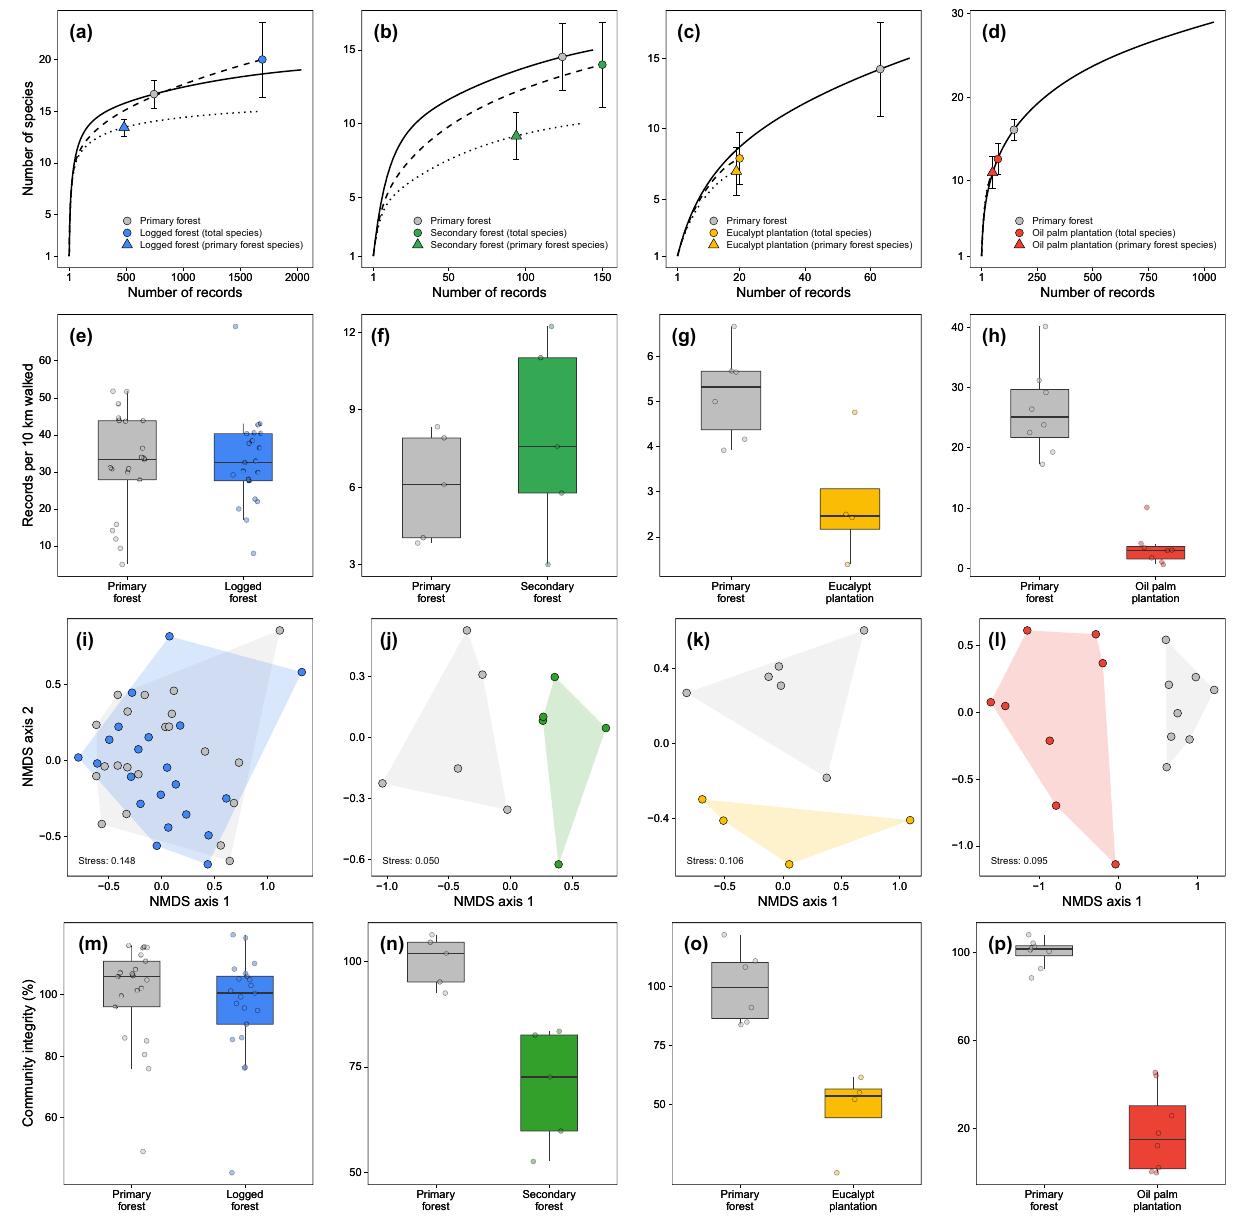
Figure 2. Mammal assemblage-wide metrics for human-modified and adjacent primary forest within each landscape: ( a – d ) rarefied total species richness in modified habitat and the adjacent primary forest, and rarefied number of primary forest species retained in modified habitat; ( e – h ) species abundance (number of records per 10 km walked); ( i – m ) species composition , represented in an ordination diagram obtained using the first two NMDS axes; and ( n – q ) community integrity , defined as the degree of similarity between disturbed and undisturbed habitats. Within each landscape, sampling sites are represented by dots and colour-coded according to habitat type: logged forest (blue), secondary forest (green), eucalyptus plantation (yellow), oil palm plantation (red) and adjacent primary forest (grey). As an exception, dots/triangles in ( a – d ) represent the rarefied number of species within each habitat type per landscape, which was obtained by further considering the number of records and corresponding sample coverage (see details in the Data